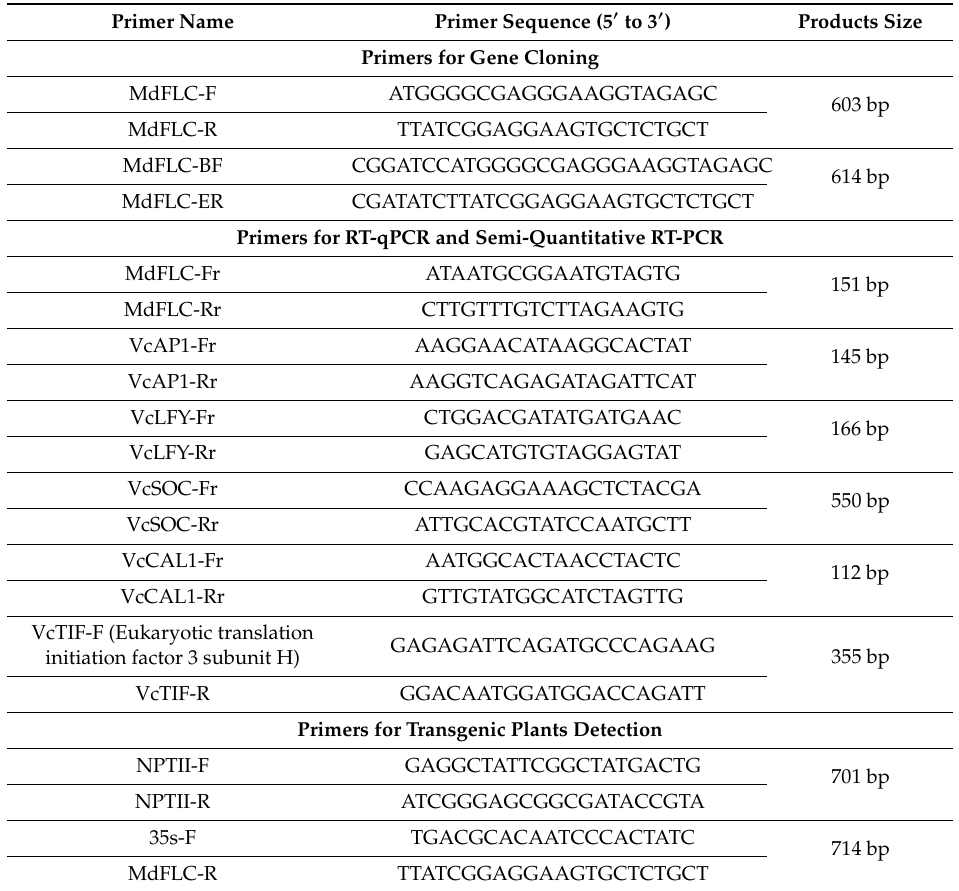
Table 2. Primers used in this